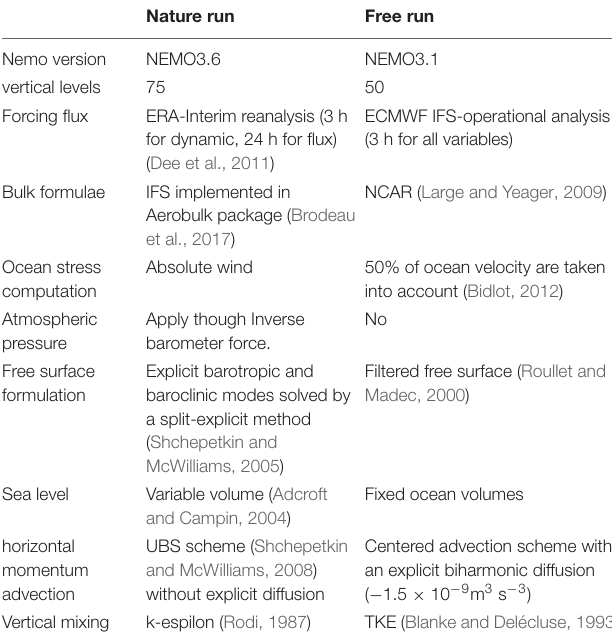
TABLE 1 | Differences in model parameterisation between (NatRun) NR and (Free Run model)